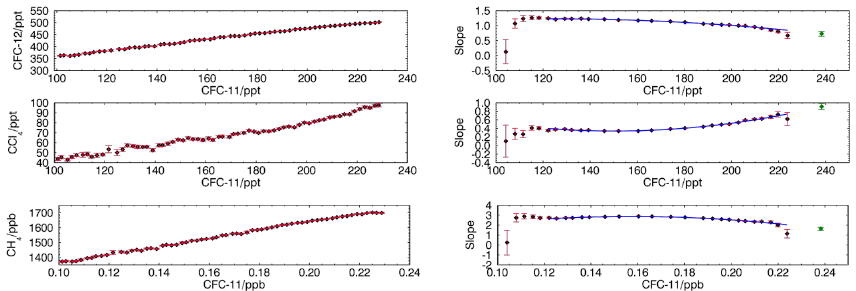
Figure B2 Correlations between the volume mixing ratios of CFC-12, CCl 4 , and CH 4 and CFC-11 for the data from the northern hemisphere during the stratospheric summer of 2007. Left panels: The mean correlation profile. Each point represents the mean of the VMR in a window of 2 ppt of CFC-11. The error on these points is the standard deviation of the data within each 2 ppt window. Right panels: The local slope of data in an 80 ppt of CFC-11 window. The error on the points is the fitting error of this fit. The blue line is a second degree polynomial fit to the local slopes. The green point is the extrapolated slope at the tropopause.